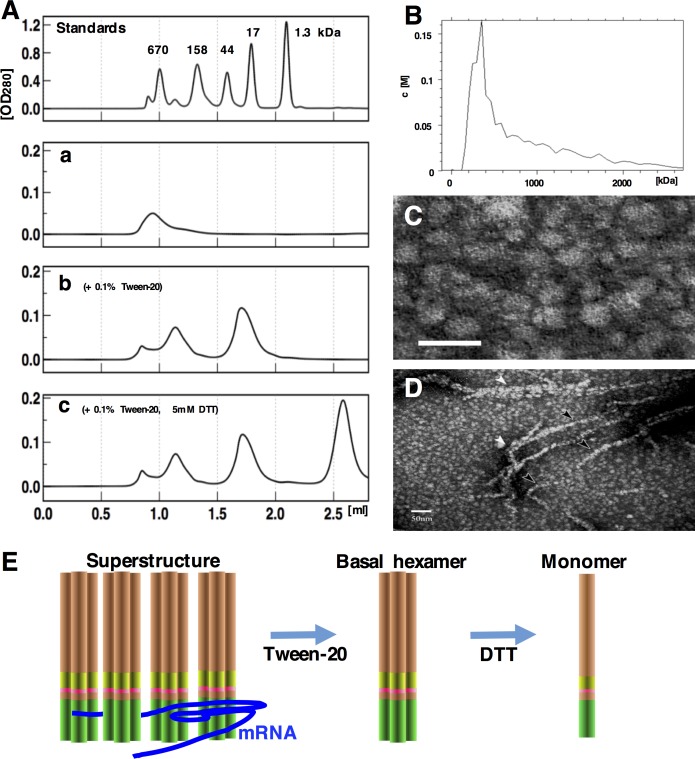
Multimer formation by RodZ.(A) Gel filtration of purified RodZwt: in RNA binding buffer [19]. Standards: Elution profile of molecular standards in the same condition: 670 kDa, thyroglobulin; 158 kDa, bovine γ-globulin; 44 kDa, ovalbumin; 17 kDa, myoglobin; 1.35 kDa, cyanocobalamin. a: Elution profile of RodZwt (0.5 mg/ml, 40 μl). b: Elution profile in RNA binding buffer containing 0.1% Tween-20. c: Elution profile in RNA binding buffer containing 0.1% Tween-20 and 5 mM dithiothreitol. (B) Analytical ultracentrifugation of RodZwt (1 mg/ml). (C) TEM image of purified RodZwt. Scale bar = 25 nm. (D) Low magnification of the same sample. (E) Illustration for the three forms of RodZ complexes.